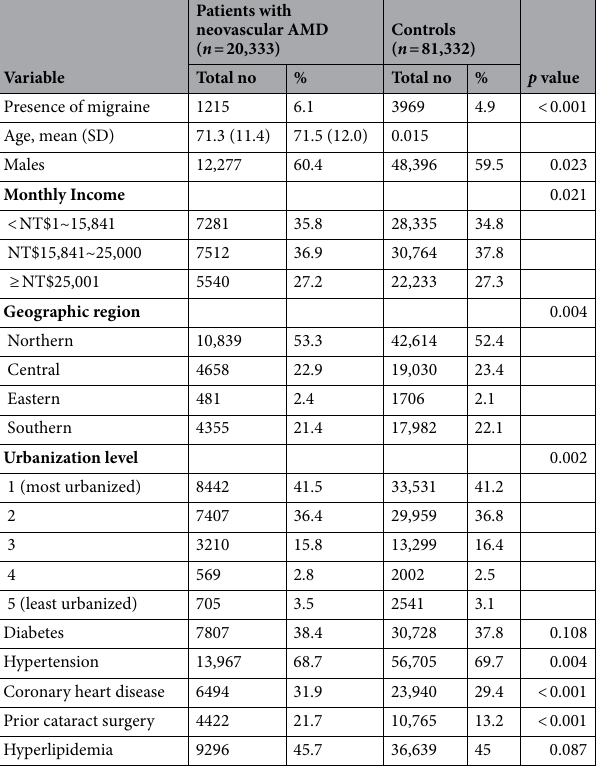
Table 1. Demographic characteristics of persons with neovascular age-related macular degeneration (AMD) and controls in Taiwan (n =